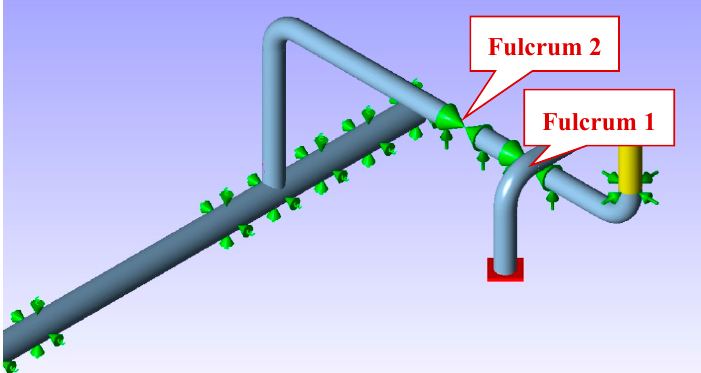
Figure 23. Foundation settlement locations. Table 12. Operation conditions of foundation settlement.